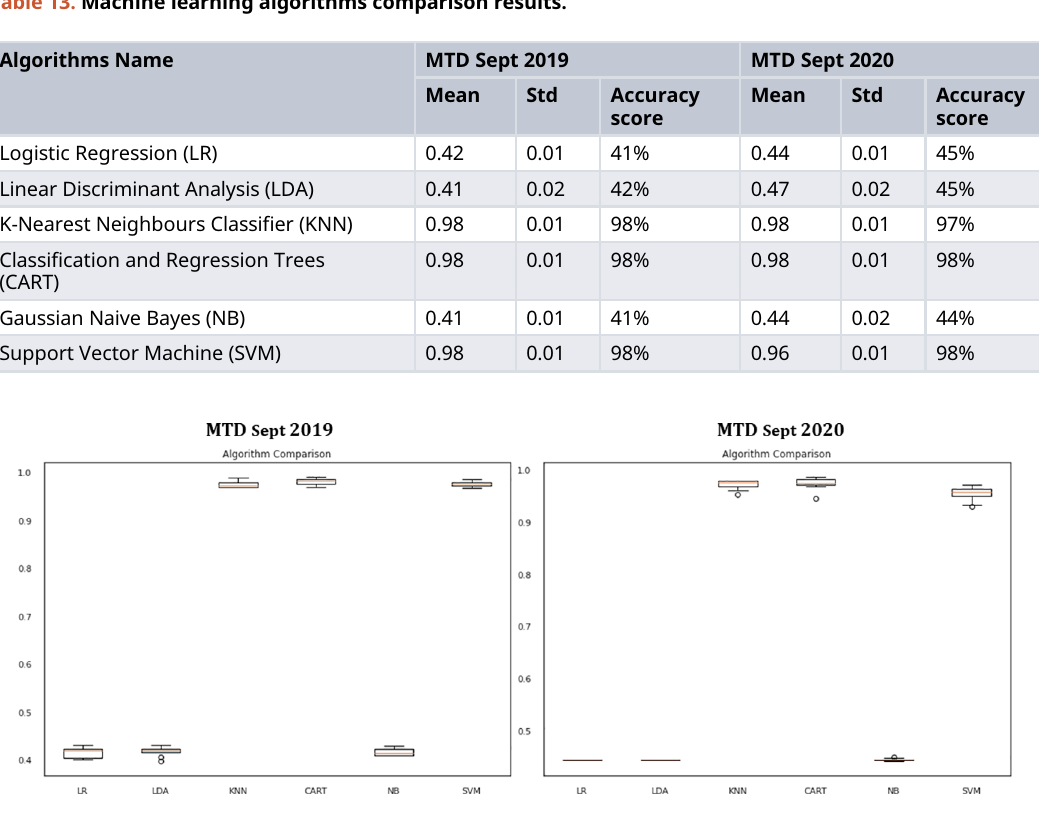
Figure 4. Comparing machine learning algorithms for MTD Sept 2019 and MTD Sept